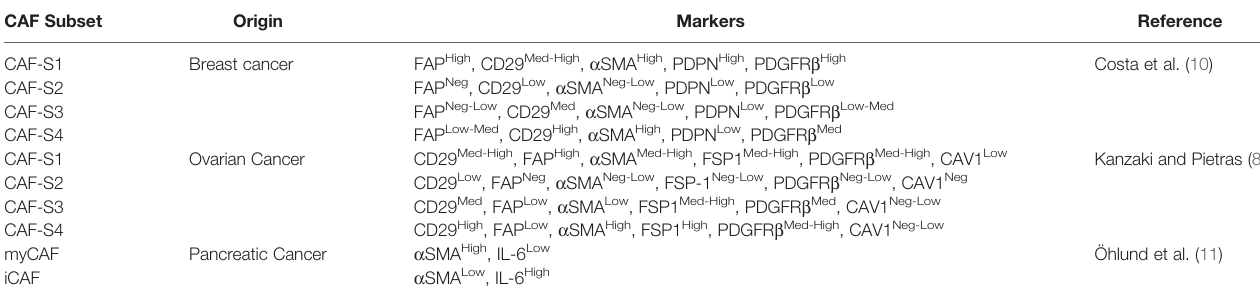
TABLE 1 | De fi nitions of CAF subsets identi fi ed in breast, ovarian and pancreatic cancer showing the differences in classi fi cations. CAF